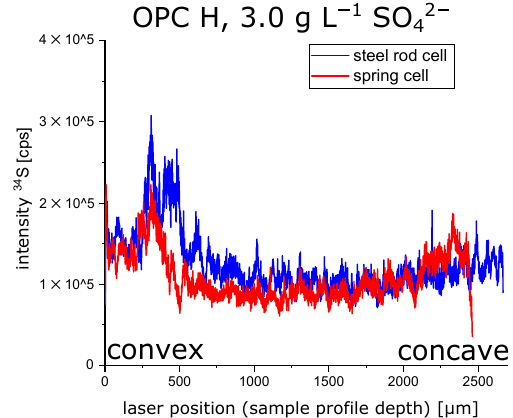
Figure 7. LA-ICP-MS profiles of the sulphur content (solid phases) over the cross-section of hollow cylinder walls (OPC H) at the time of mechanical failure of the samples after 38 days (non-constrained stress cell) and 59 days (constrained stress cell) of storage in 3.0gL SO 2– 4 , respectively.